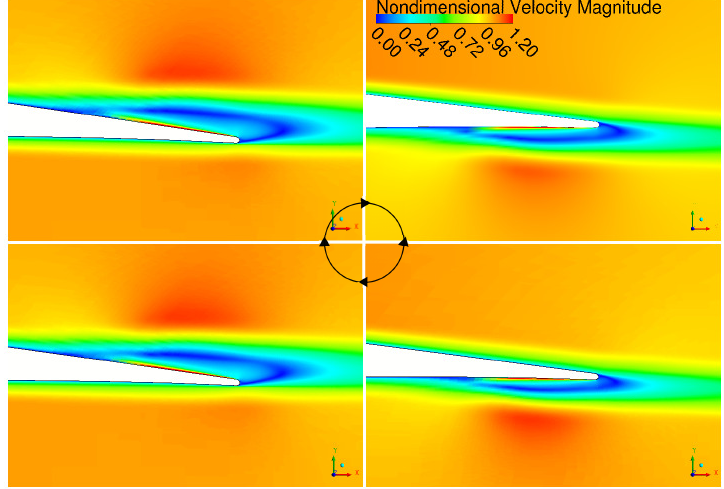
Figure 13. Trailing edge detail of velocity magnitude, normalized by the freestream velocity, at four time instants of the oscillation cycle; plasma actuation on; Re ∼ 195,000; IBPA = − 51.43 deg.; α = 2 + sin2 π f t + 4 × IBPA π /180 deg.; f = 19.17 Hz, T =